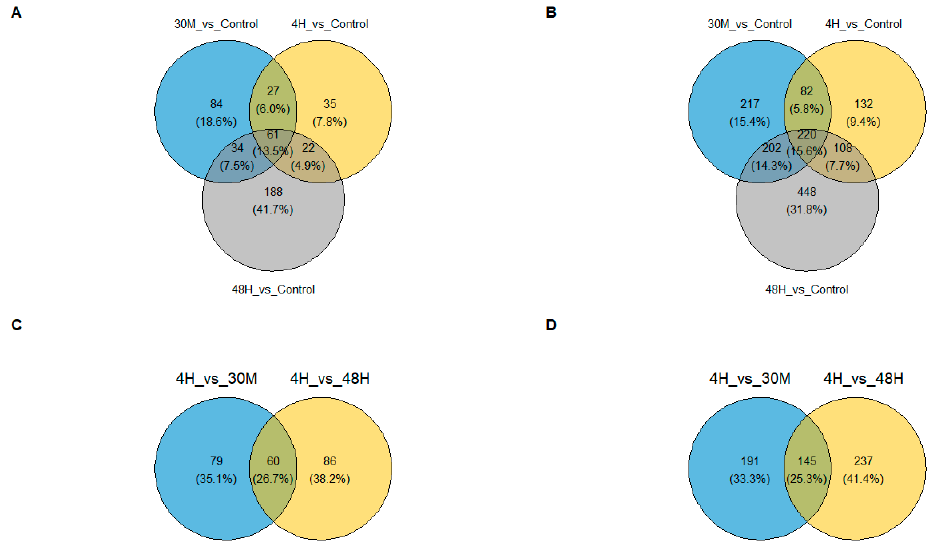
Figure 2. Receptive endometrial analogue RL95-2 cells were treated with trophoblast analogue Jar cell-derived EVs for 30 min, 4 h and 48 h to investigate the effect of trophoblastic EVs on endometrial transcriptome. ( A , C ) The Venn diagram depicts the relationship between the genes upregulated (FDR < 0.05, logFC > 1). ( B , D ) The Venn diagram depicts the relationship between the genes downregulated (FDR < 0.05, logFC < − 1).